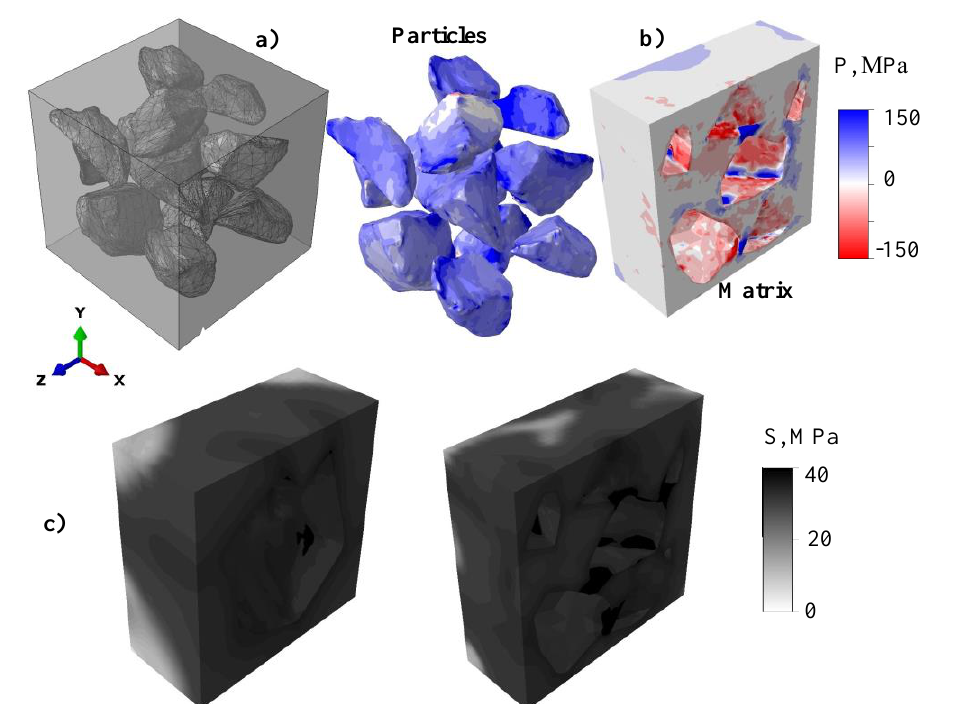
Fig. 4. Microvolume with 12 particles (a) and formation of local regions of bulk tension under cooling of the composite (b). Volume fraction of particles is 20 %. Equivalent stress patterns (c) in the aluminium matrix for microstructures shown in Figs. 2a and